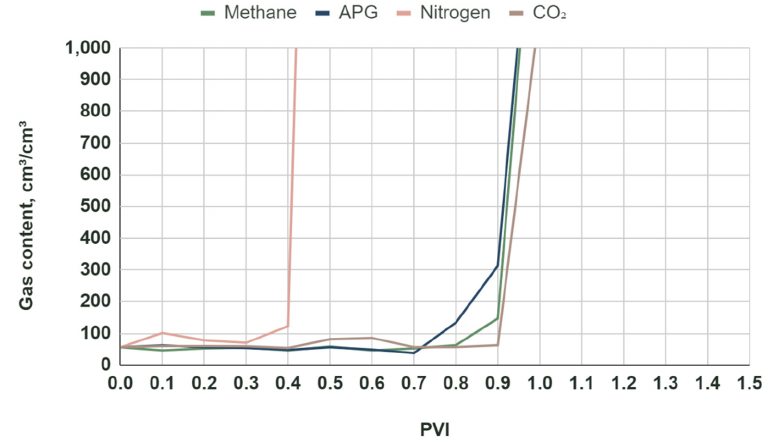
Figure 5. Gas content dynamics at an injection pressure of 40 MPa.